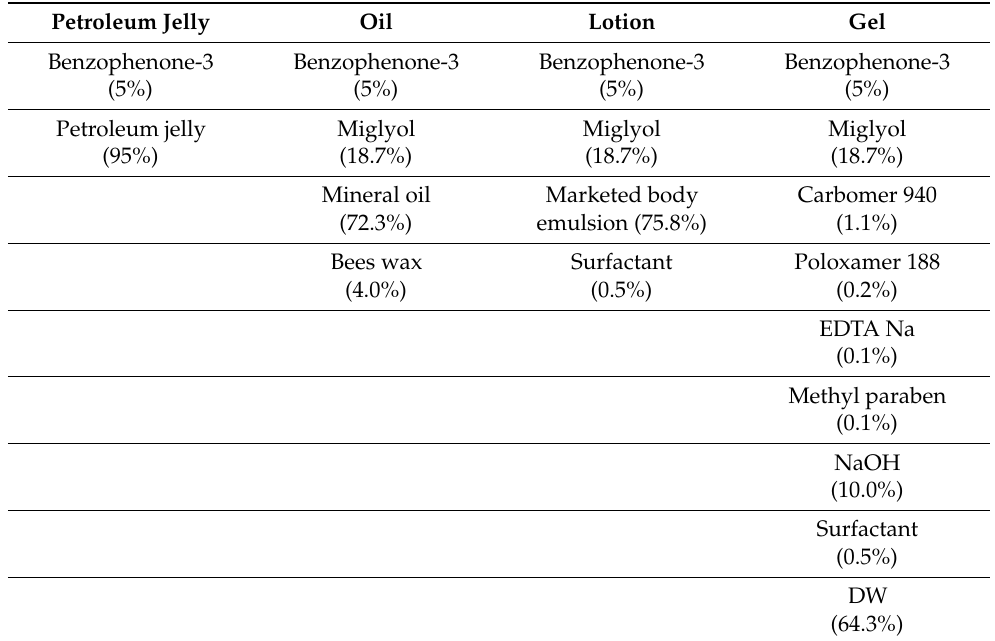
Table 1. Composition of BP-3